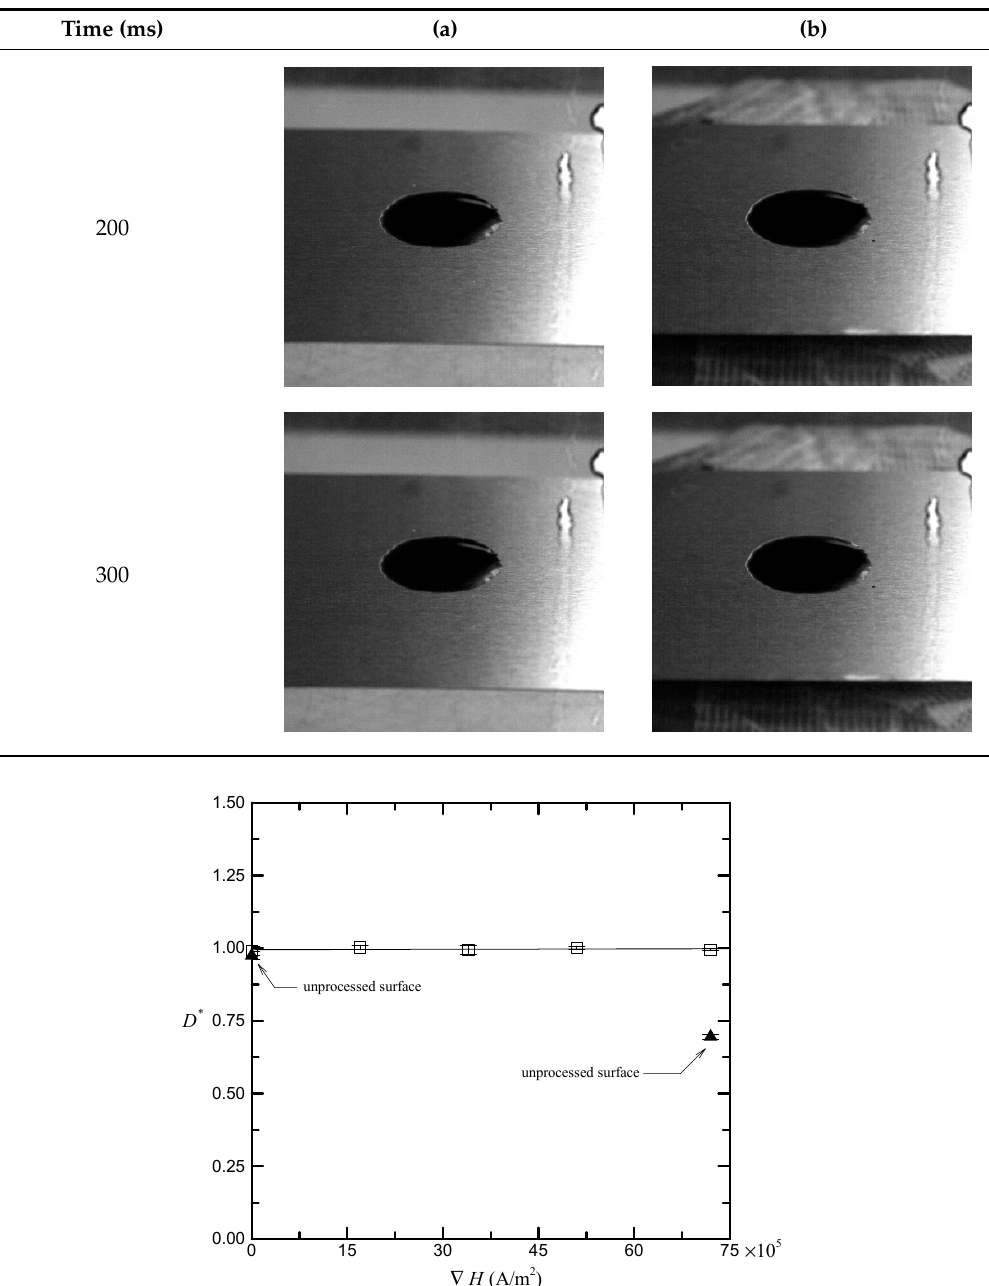
Figure 2. Reduced diameter versus magnetic field.